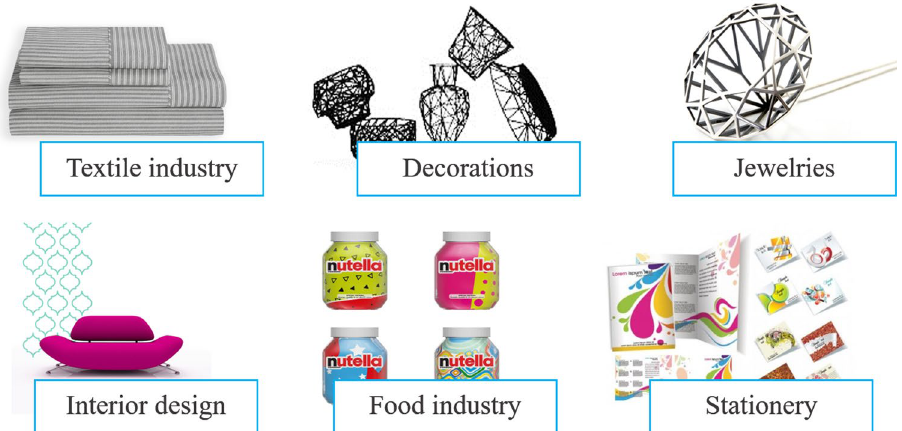
Fig. 3 Application areas of